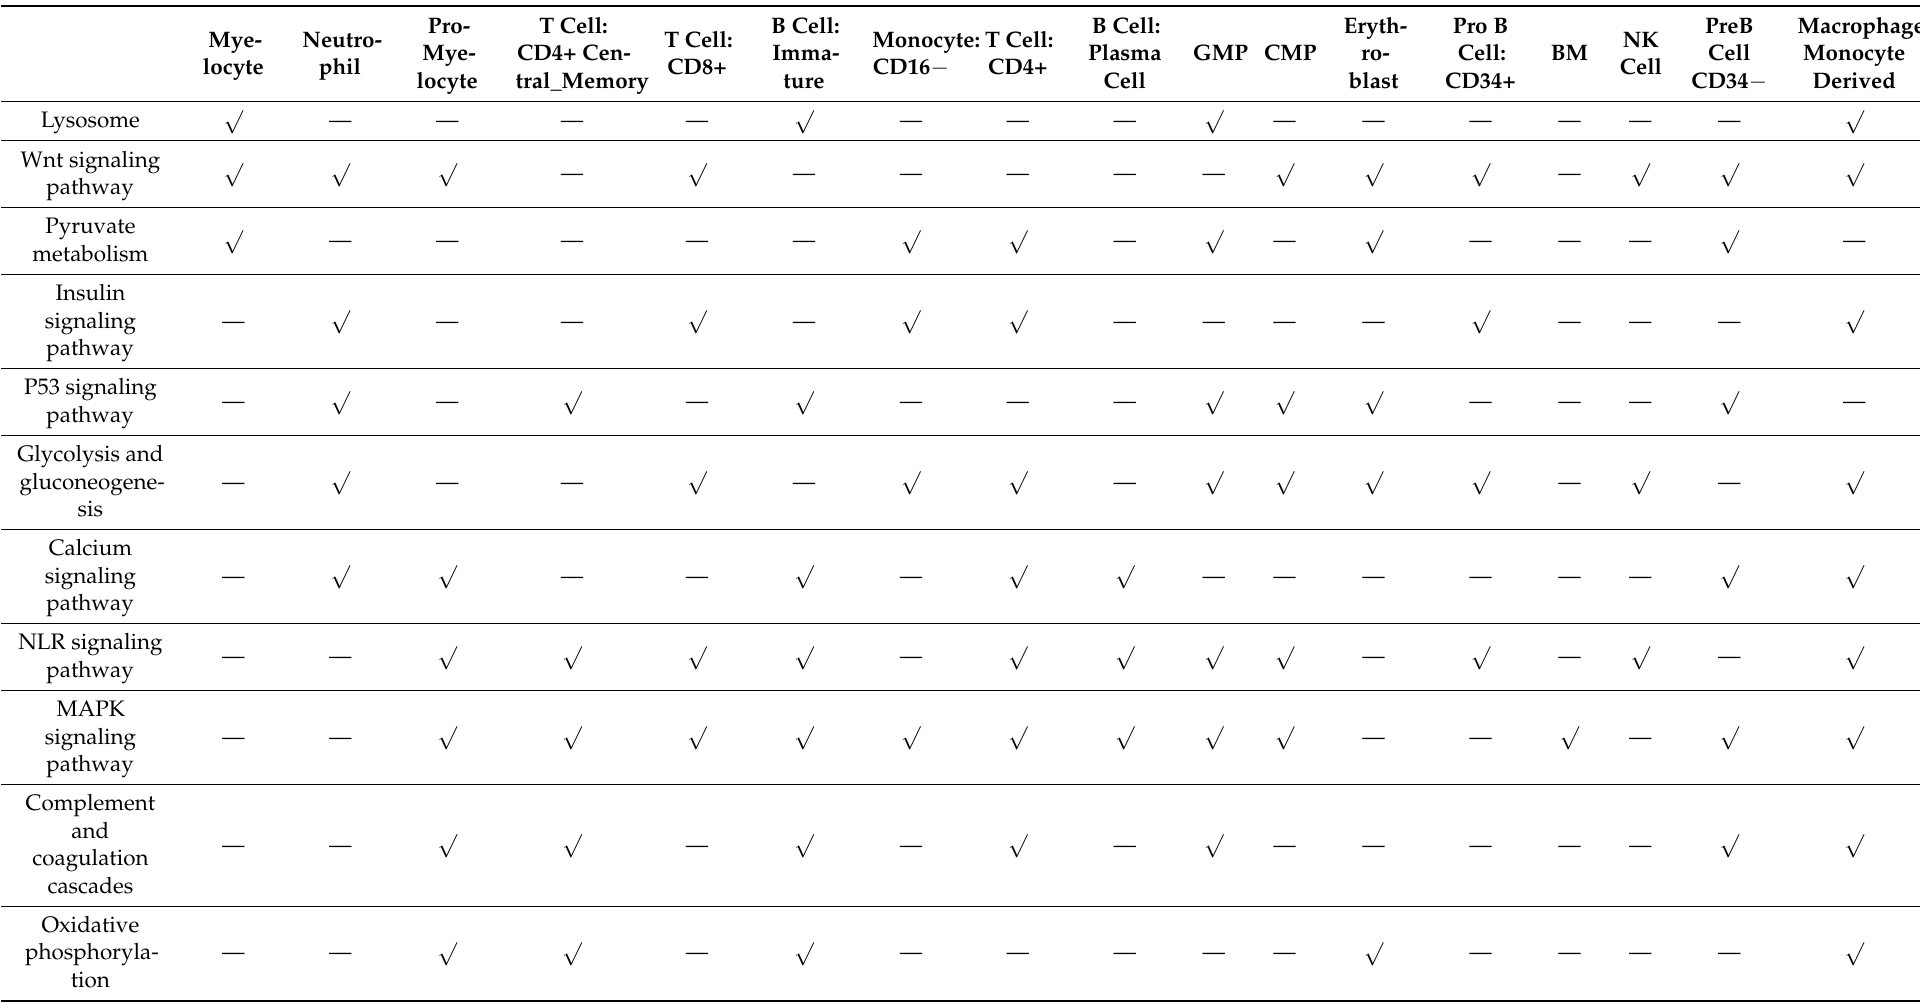
Table 1. The affected signaling pathways in various cell types in bone marrow. PPAR: peroxisome proliferators-activated receptor, NLR: NOD-like receptor, TLR: toll-like receptor, MAPK: mitogen-activated protein kinase. Pro- Mye- Neutro- Mye- CD4+ Cen- locyte phil locyte Lysosome Wnt signaling pathway Pyruvate metabolism Insulin signaling pathway P53 signaling pathway Glycolysis and gluconeogene- Calcium signaling pathway NLR signaling pathway MAPK signaling